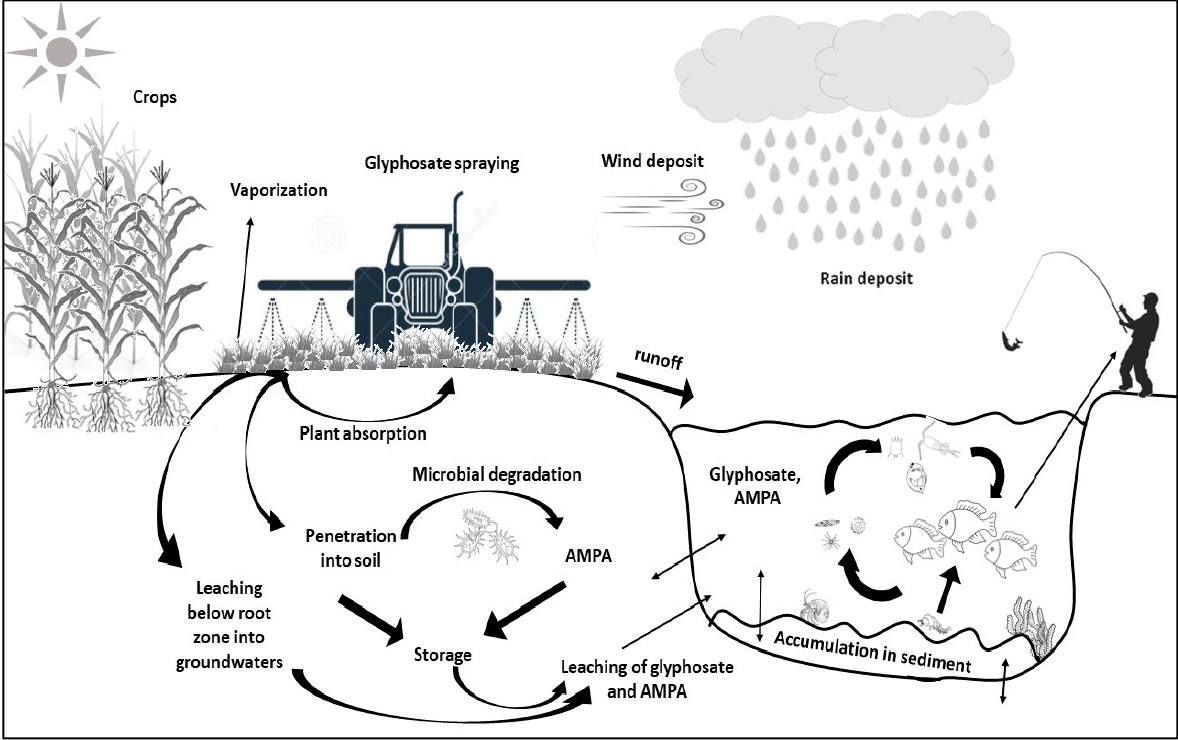
Figure 1. Distribution and transport of glyphosate and its major metabolite AMPA into the aquatic environment.